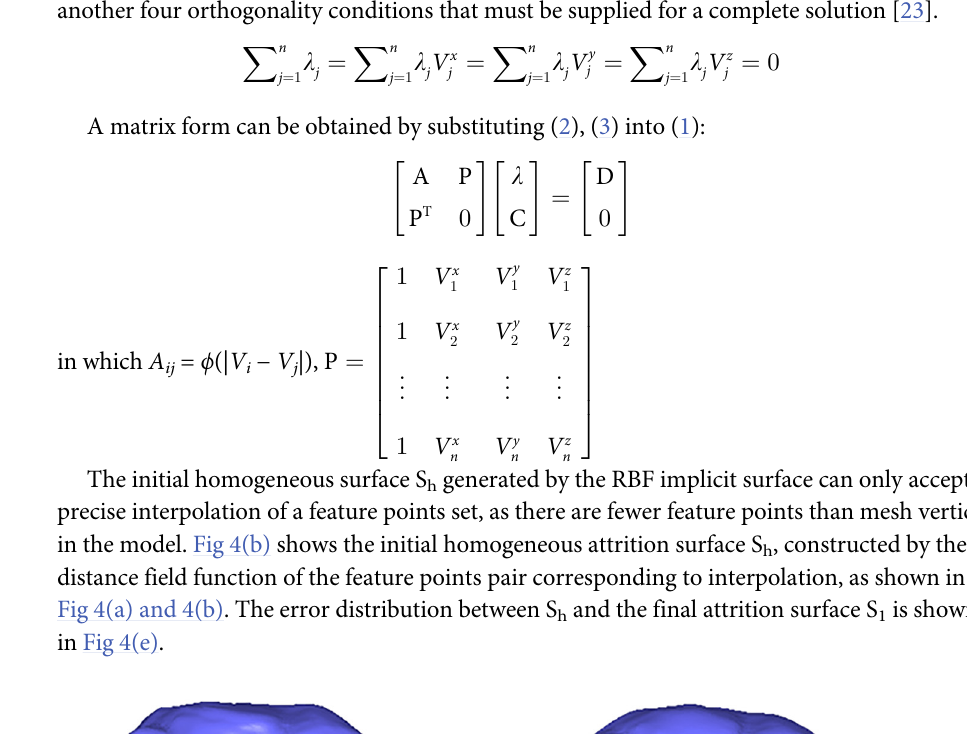
PLOS ONE | DOI:10.1371/journal.pone.0134807 August 4,